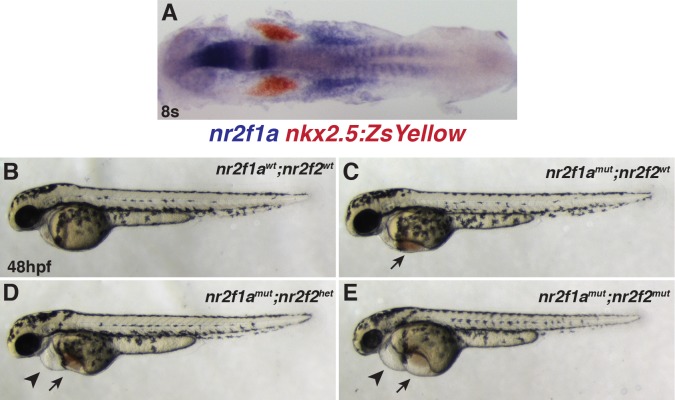
Loss of nr2f2 alleles in nr2f1a mutants produces stronger overt cardiovascular defects.(A) Two-color ISH for nr2f1a (blue) and nkx2.5:ZsYellow (red) at the 8s stage. Embryo is flat-mounted with dorsal view and anterior left. (B-E) Lateral views of the nr2f1awt; nr2f2wt, nr2f1amut; nr2f2wt, nr2f1amut; nr2f2het, and nr2f1amut; nr2f2mut embryos. n = 16 overtly WT embryos and n = 32 embryos with edema that were genotyped for the experiment shown. While embryos that have two WT alleles are shown, the other combinations of nr2f1a and nr2f2 alleles, other than nr2f1ahet; nr2f2mut embryos, were indistinguishable from WT embryos at 48 hpf. 1 of 5 embryos that genotyped as nr2f1ahet; nr2f2mut embryos was indistinguishable from WT, while 4 of the 5 nr2f1ahet; nr2f2mut embryos displayed a very small amount of blood pooling on the yolk. However, cardiac defects were not found in these embryos. Arrows indicate edema and blood pooling on the yolk. Arrowheads indicated pericardial edema.